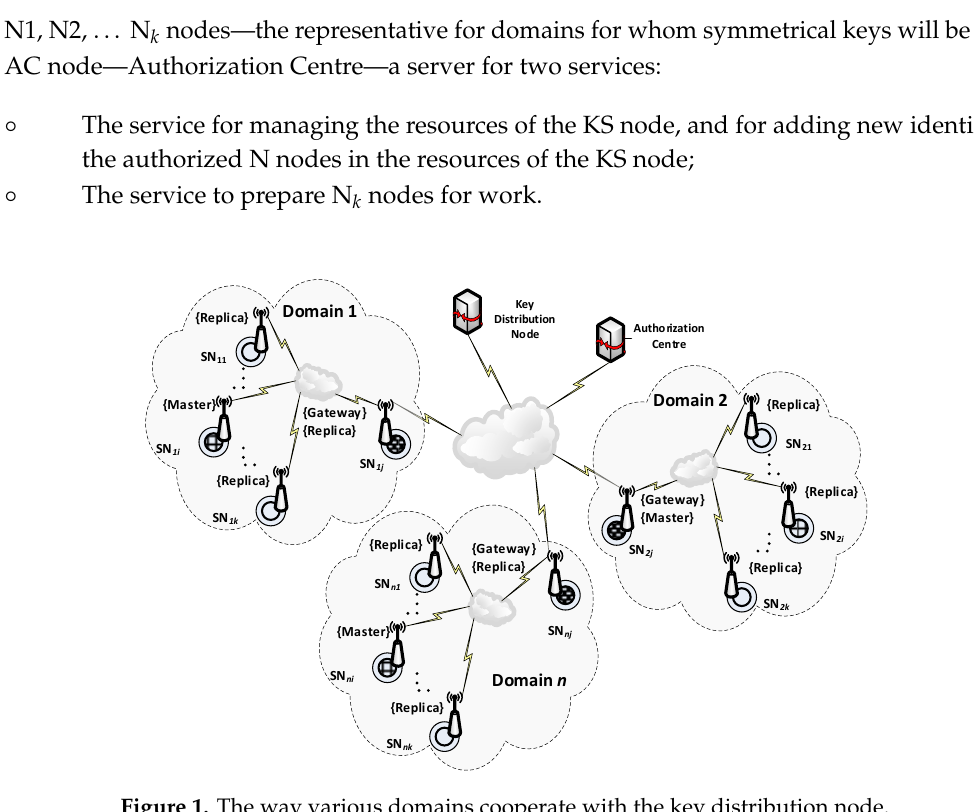
Figure 2. Sequence diagram of key generation for node pair N m and N n.